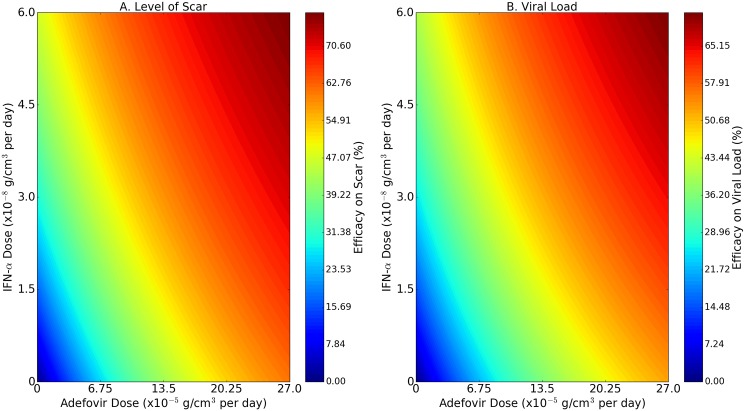
Efficacy map in combination therapy with IFN-α and adefovir.The horizontal axes scale the fractions for the dose of IFN-α and the vertical axes scale the fractions for the dose of adefovir. The color maps represent the efficacies of reduction in the level of scar density (A) and the viral load (B) at day 180 of infection.